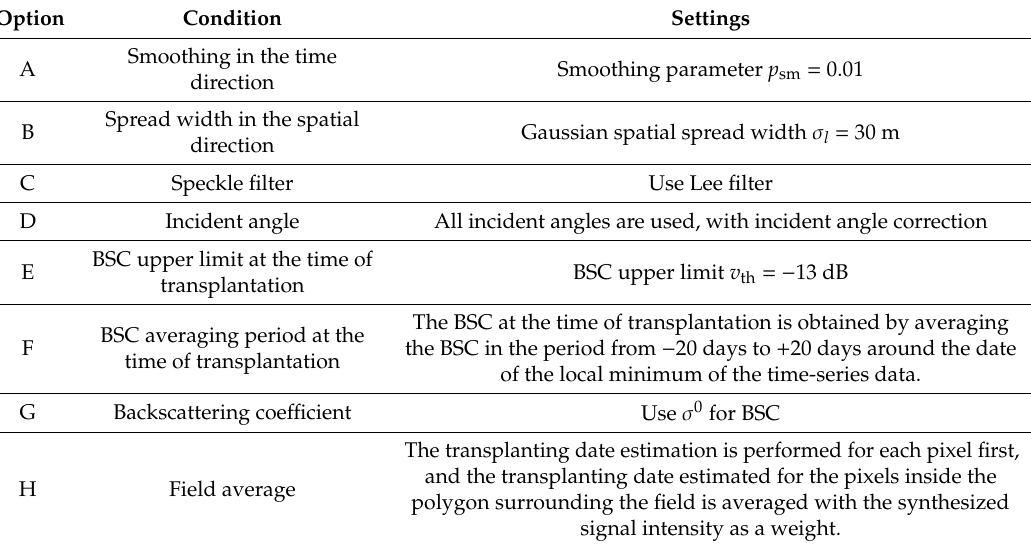
Figure 2. Map of transplanting date block values at the test site (first crop in the dry season of 2019). The 250ha test site is divided into 25 irrigation blocks, which are color-coded by the transplanting date (block value) obtained from the interview survey for each block. Table 2. Default settings for transplanting date